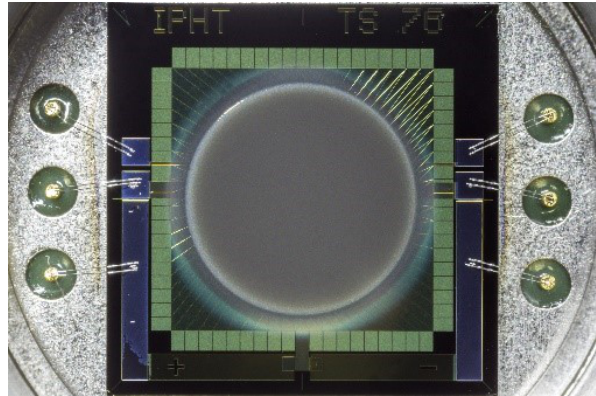
Figure 6. TS-76 sensitive area with 76